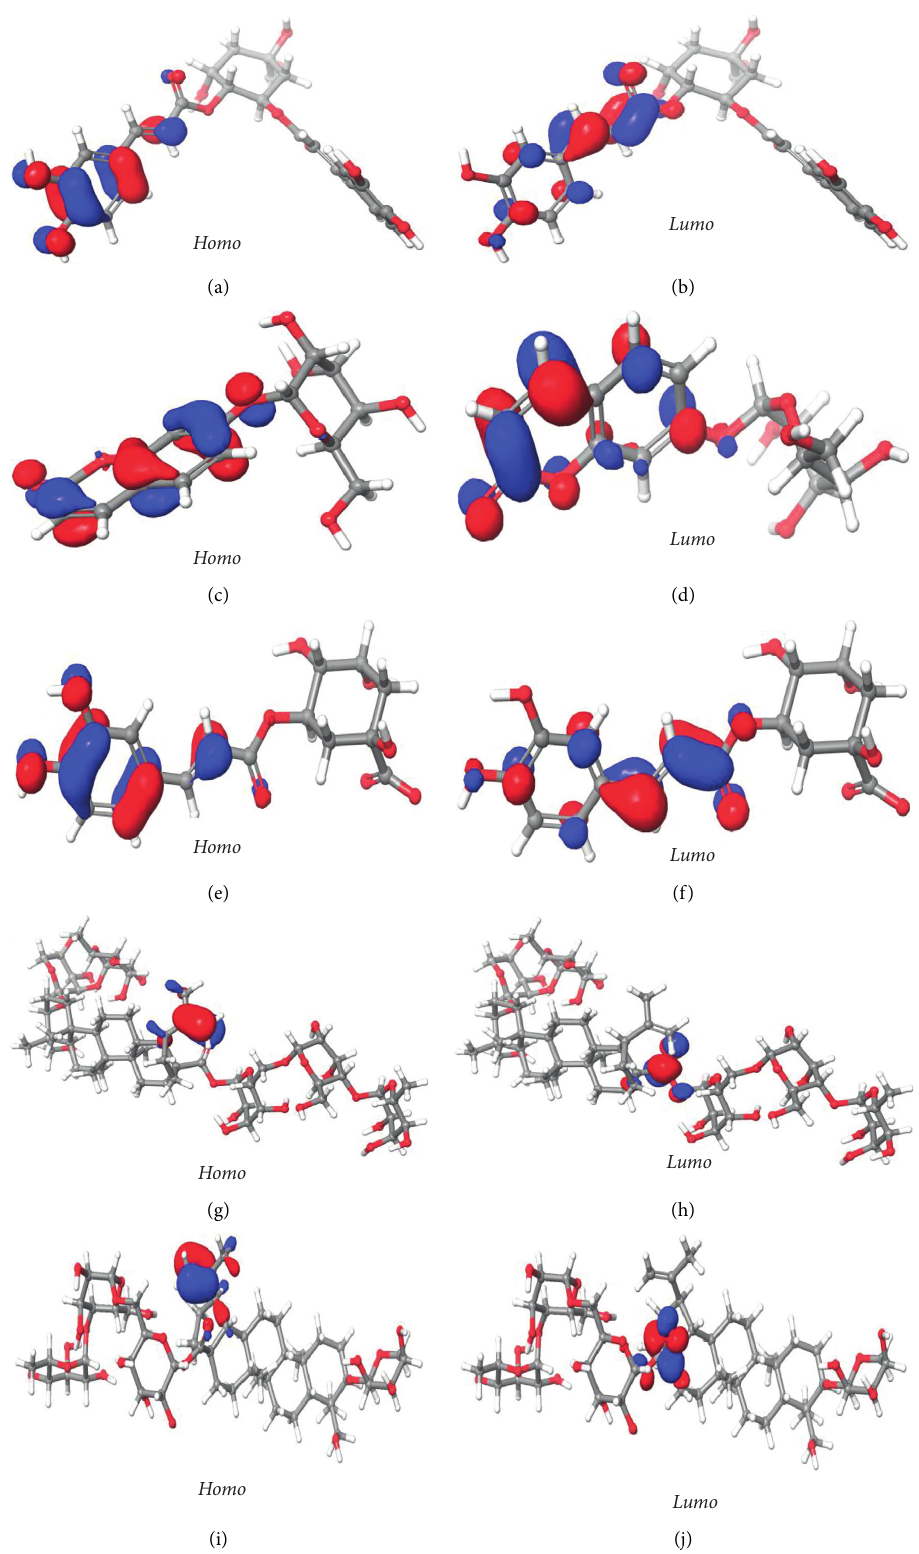
Figure 3: HOMO and LUMO mapping of 3802778 (a, b), 32036 (c, d), 5315832 (e, f), 14590080 (g, h), and 74029795 (i, j) homeopathy compounds. Blue and red color regions represent positive and negative potential,